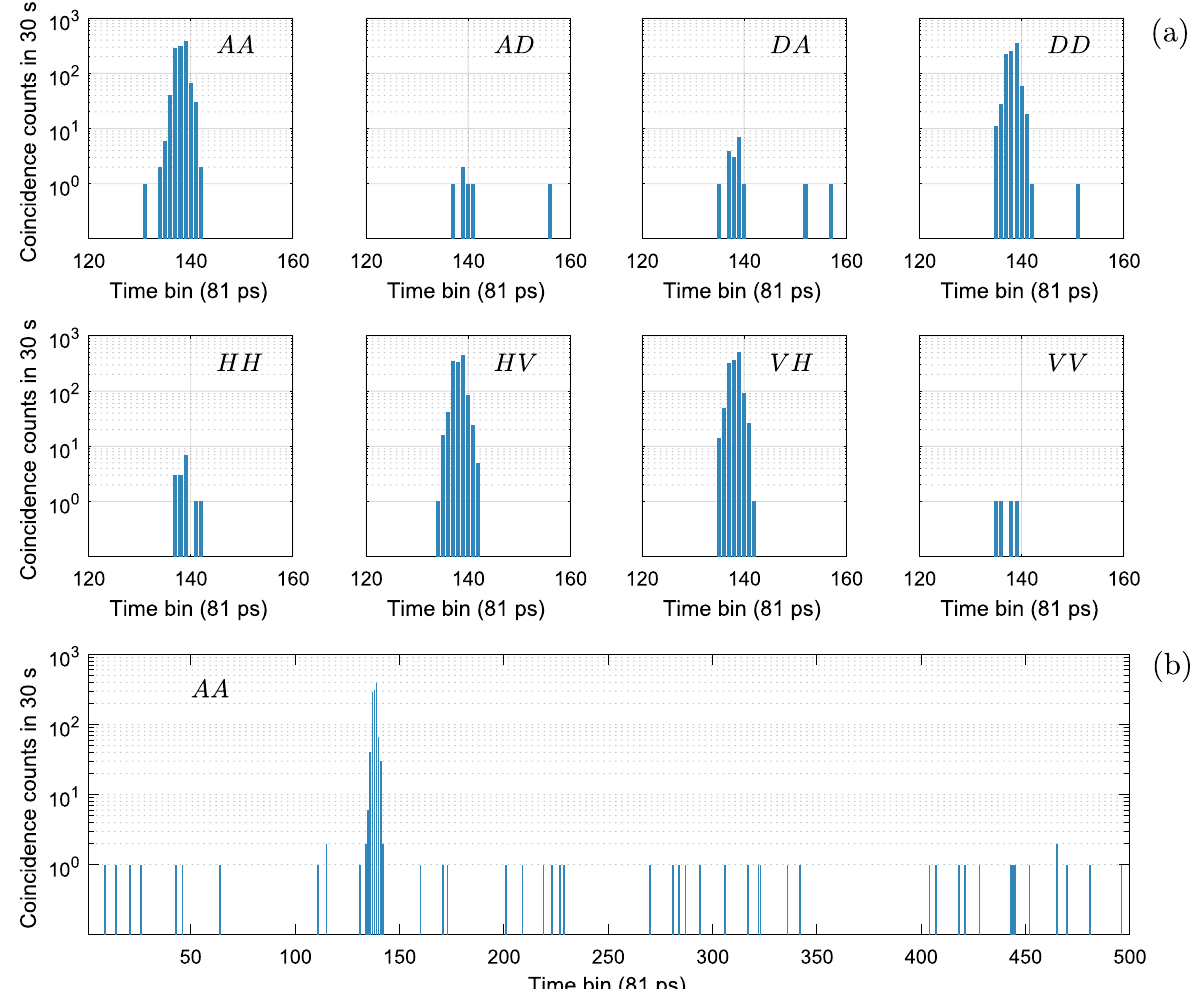
Fig. 7 Raw data for time-correlation histograms. a Measured time-correlation histograms for the 8 projective measurements performed to obtain the lower bound on F for 100 GHz ITU channels 23 (1558.98 nm) and 29 (1554.13 nm). b Extended time-correlation histogram in the AA con fi guration showing the low level of recorded background